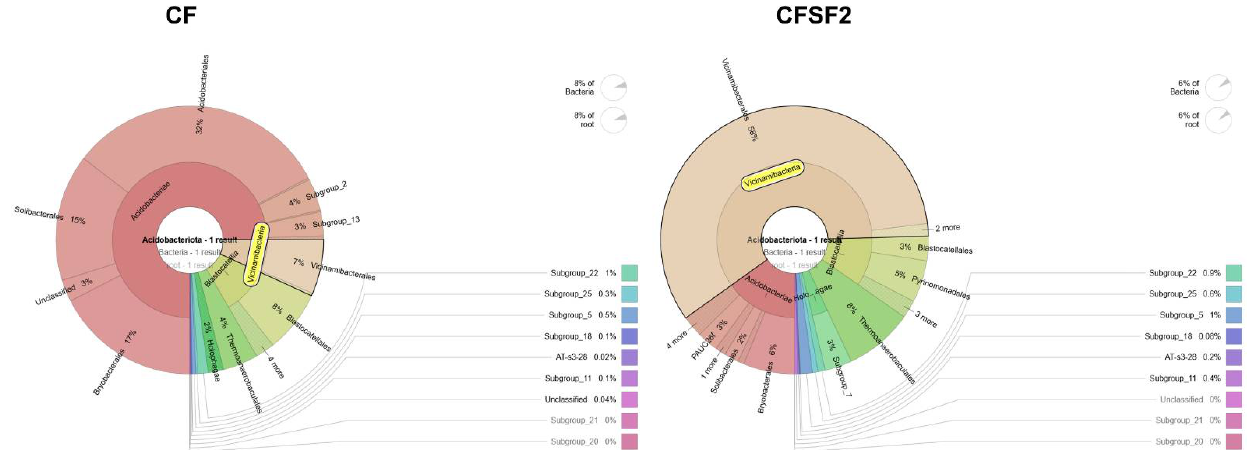
Figure 6. Krona plot showing the analysis results of Vicinamibacterales in CF and CFSF2. Circles from inside to outside stand for different taxonomic ranks, and the area of the sector shows the respective proportion of different OUT annotation results.